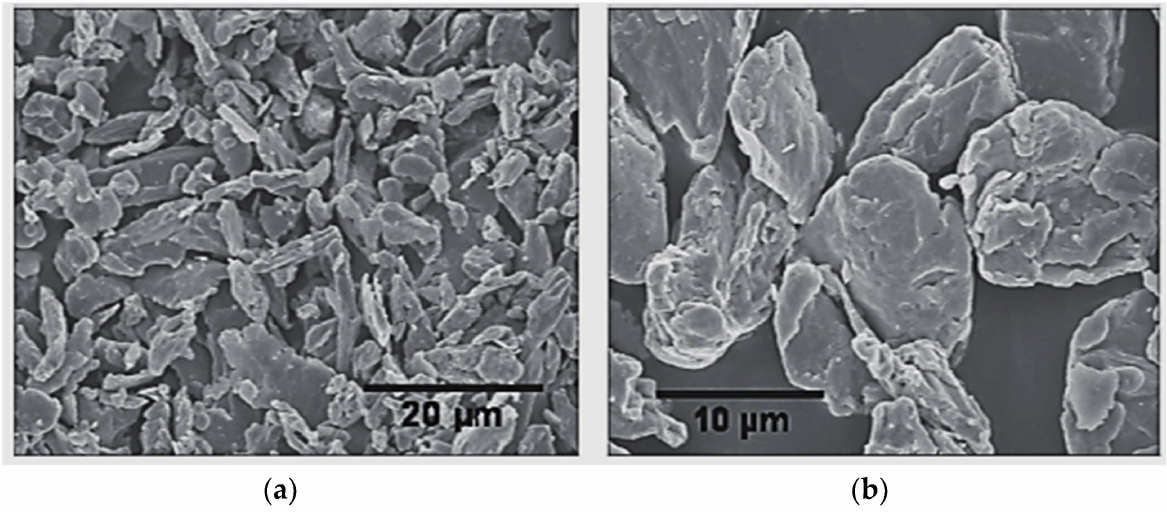
Figure 2. Morphology of the microstructure of iron plate-like particles in ( a ) small-sized particles and ( b ) large-sized particles